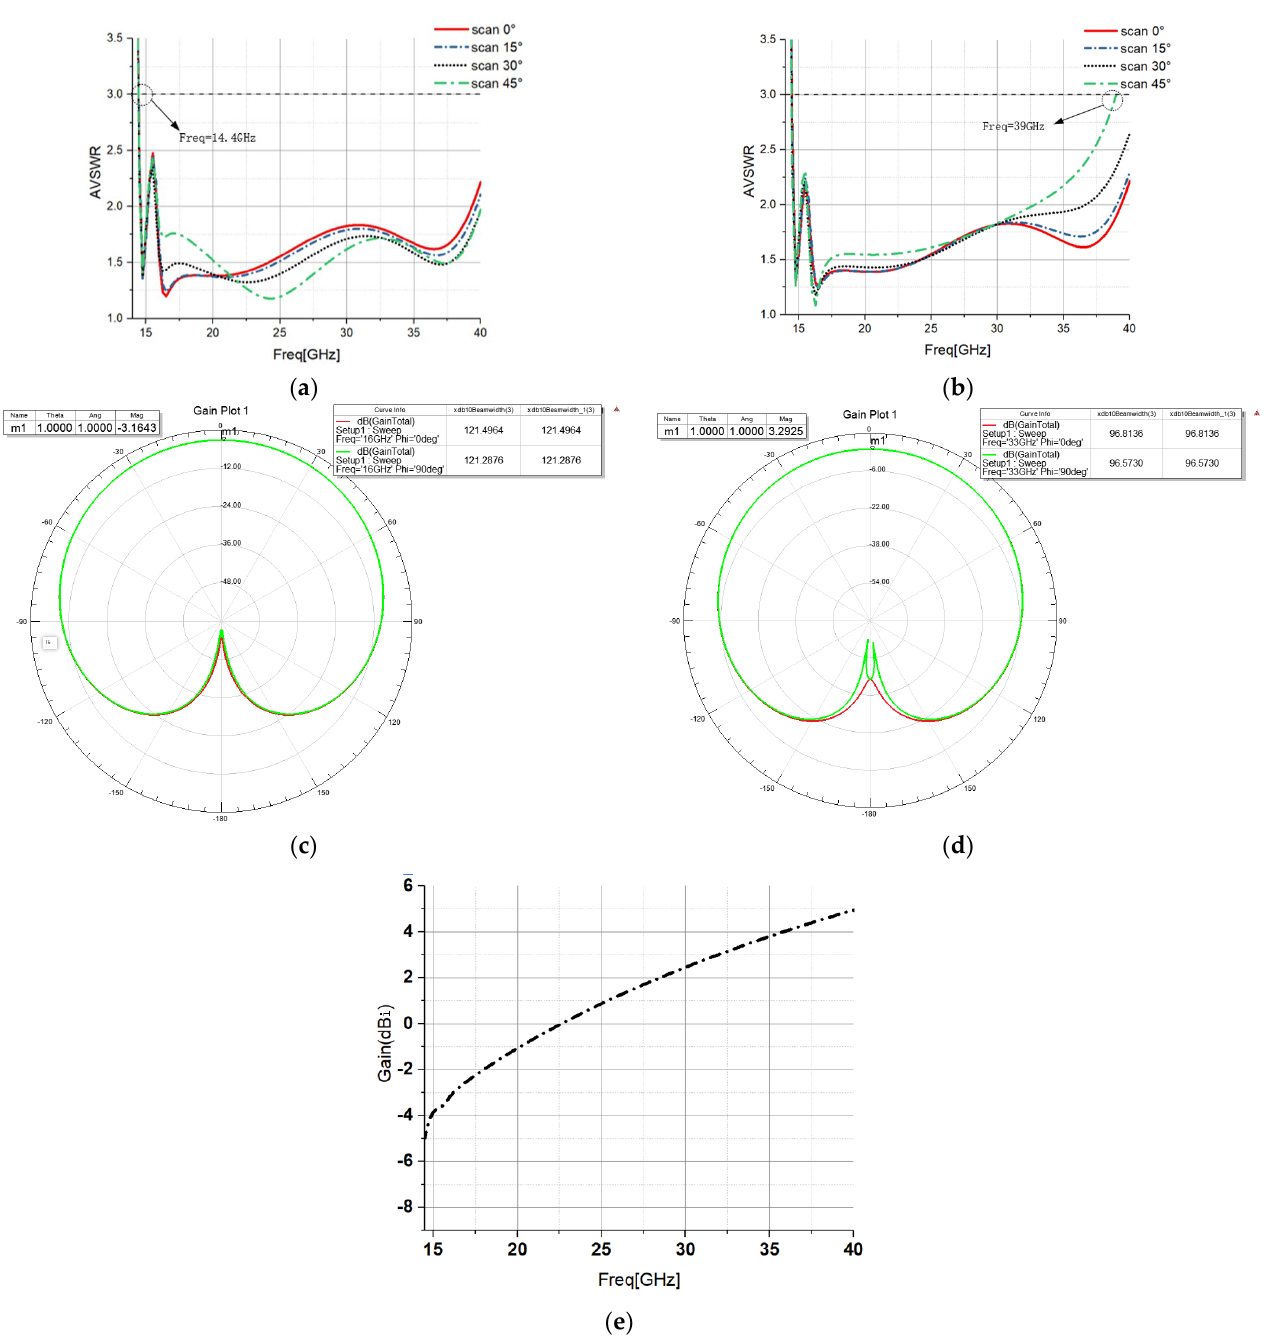
Figure 2. Electrical performance of dual-polarization tightly coupled antenna: ( a ) Plane E active standing wave; ( b ) Plane H active standing wave; ( c ) 16 GHz direction pattern result; ( d ) 33 GHz direction pattern result; and ( e ) Gain result.